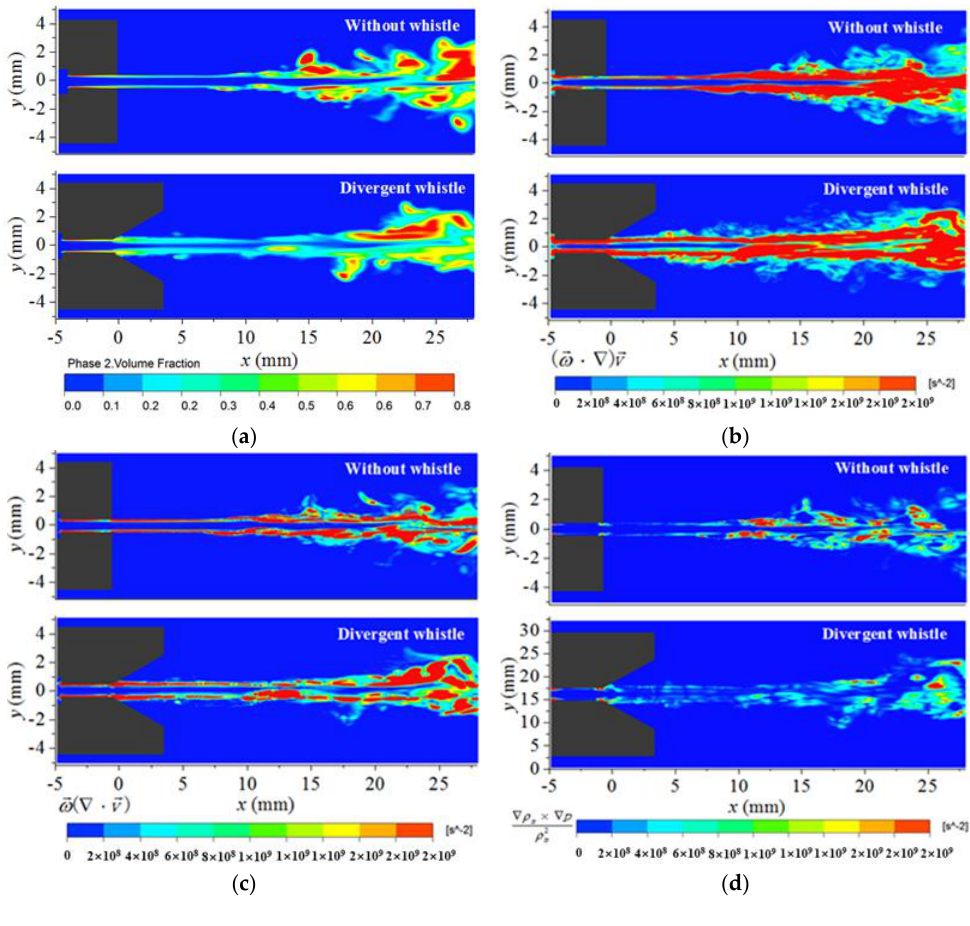
Figure 13. Different turns of vorticity transport equations of different nozzles. ( a ) Cavity volume fraction. ( b ) Vorticity extension term. ( c ) Vorticity expansion term. ( d ) Vorticity baroclinic term.